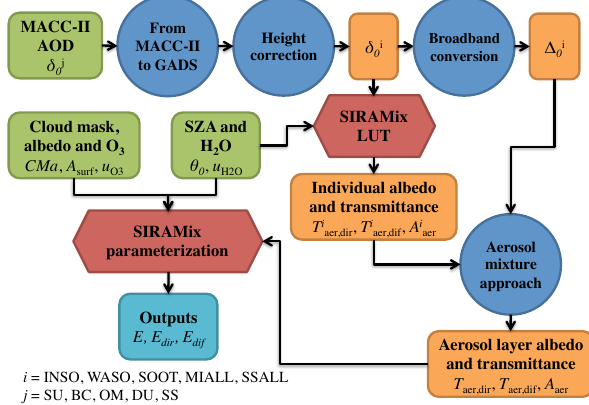
Figure 2. Block scheme of the approach SIRAMix and the use of the inputs. The parameterization and LUT of SIRAMix are illus- trated in red boxes. Inputs are drawn in green, intermediate products in orange, and outputs in light blue. The different processing steps are depicted in dark blue